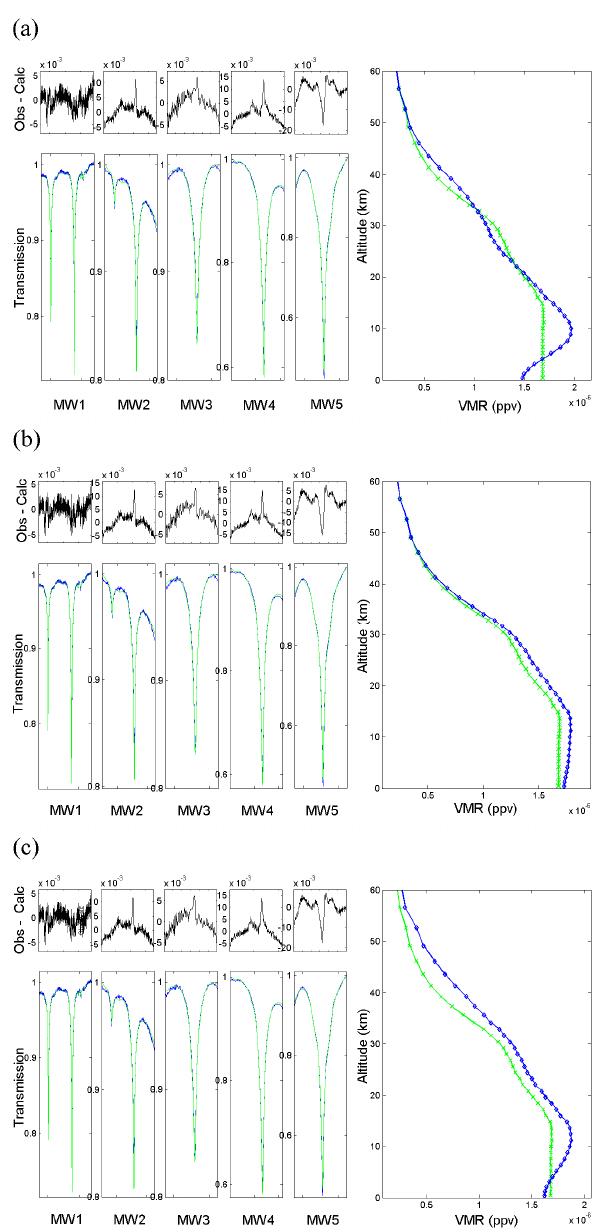
Figure 7. Multiple micro-window (MW1: 2613.70 – 2615.40, MW2: 2650.60 – 2651.30, Fig. 7. Multiple micro-window (MW1: 2613.70–2615.40, MW2: 2650.60–2651.30, MW3: 2835.50–2835.80, MW4: 2903.60– MW3: 2835.50 – 2835.80, MW4: 2903.60 – 2904.03, and MW5: 2921.00 – 2921.60 2904.03, and MW5: 2921.00–2921.60 cm − 1 ) fit of CH 4 plus in- terfering species from a single spectrum on 2 October 2007 at St.- cm -1 ) fit of CH plus interfering species from a single spectrum on October 2, 2007 at St.- 4 Denis using the (a) OEM, (b) IOA and (c) TR. Measured (blue) and simulated (green) spectra are shown (left lower plot), together with the residuals (left upper plot), computed as measured minus simu- lated. The right plot shows the a priori (green crosses) and retrieved (blue diamonds)